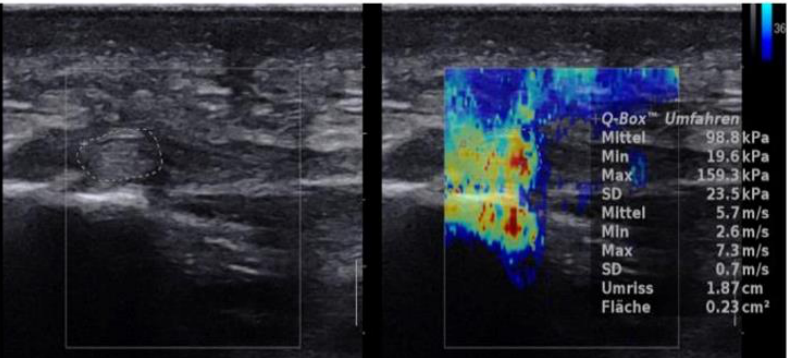
Figure 2. Longitudinal SWE image and B-mode ultrasound image of a 50-year-old patient with normal plantar fascia demonstrates stiffness of 98.8 kPa and SWV value of 5.7 m/s.